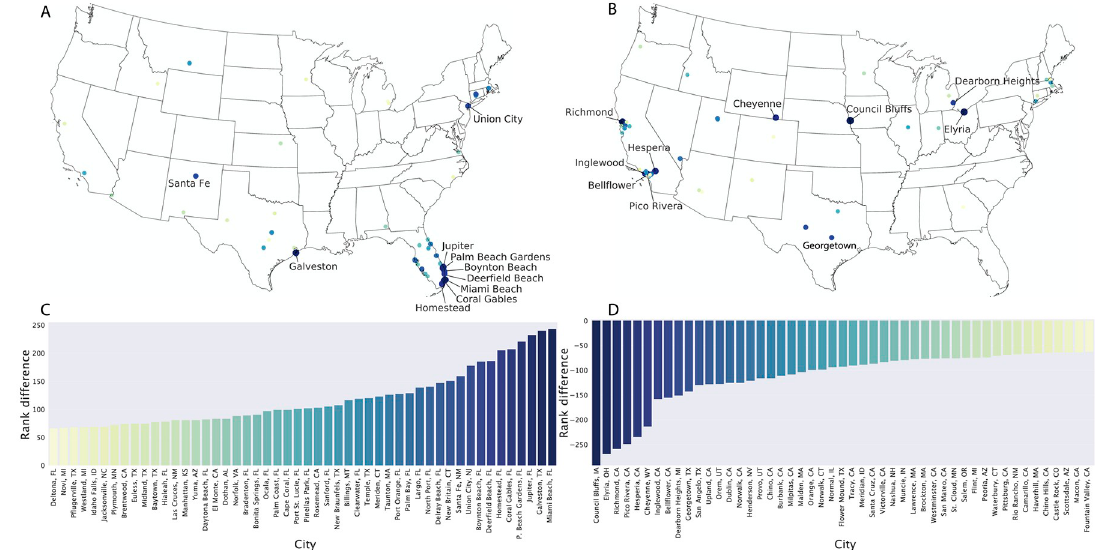
Fig 3. Spatial patterns of attention. Cities of the United States, with population higher than 40,000, where the volume of attention to ZIKV related pages was higher (panel A) or lower (panel B) than expected based on the total volume of pageviews to Wikipedia in 2016. The maps only show the 50 cities with the largest positive (panel C) or negative (panel D) difference in their pageview rankings, based on ZIKV related pages and the full Wikipedia. The labels on the maps highlight the 10 cities with highest (panel A) or lowest attention (panel